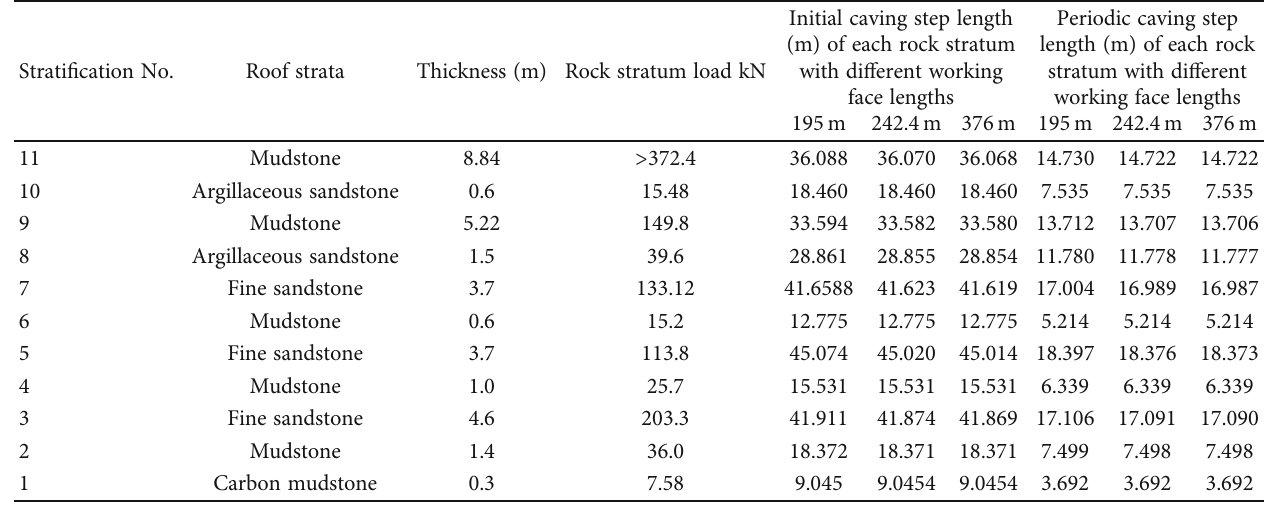
Table 2: Load, initial caving step length, and periodic caving step length of roof of No. 3 coal seam.